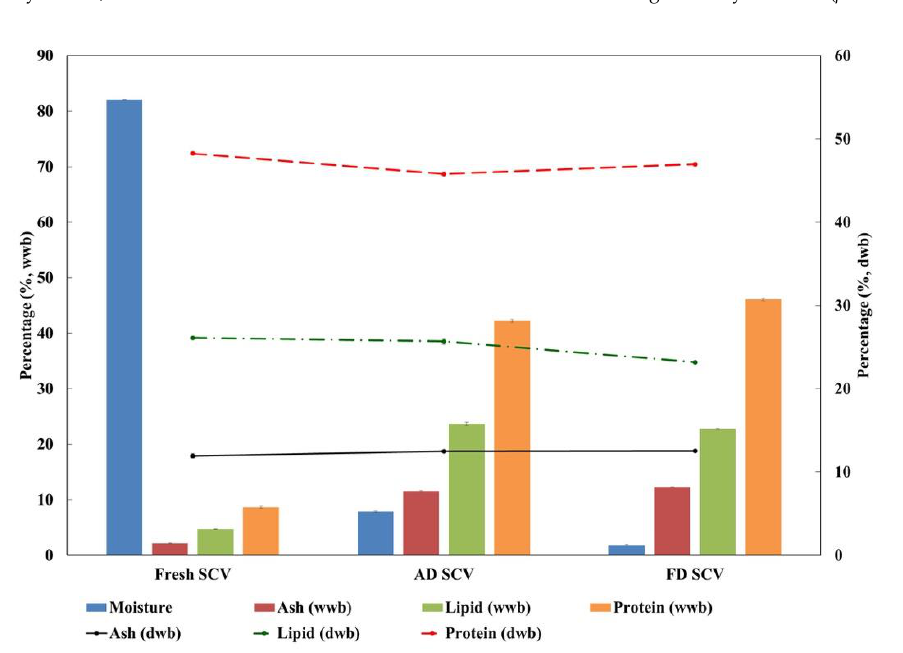
Figure 4. Proximate composition of fresh, air-dried (AD SCV) and freeze-dried (FD SCV) sea cucumber viscera (wwb: wet weight basis, dwb: dry weight basis).